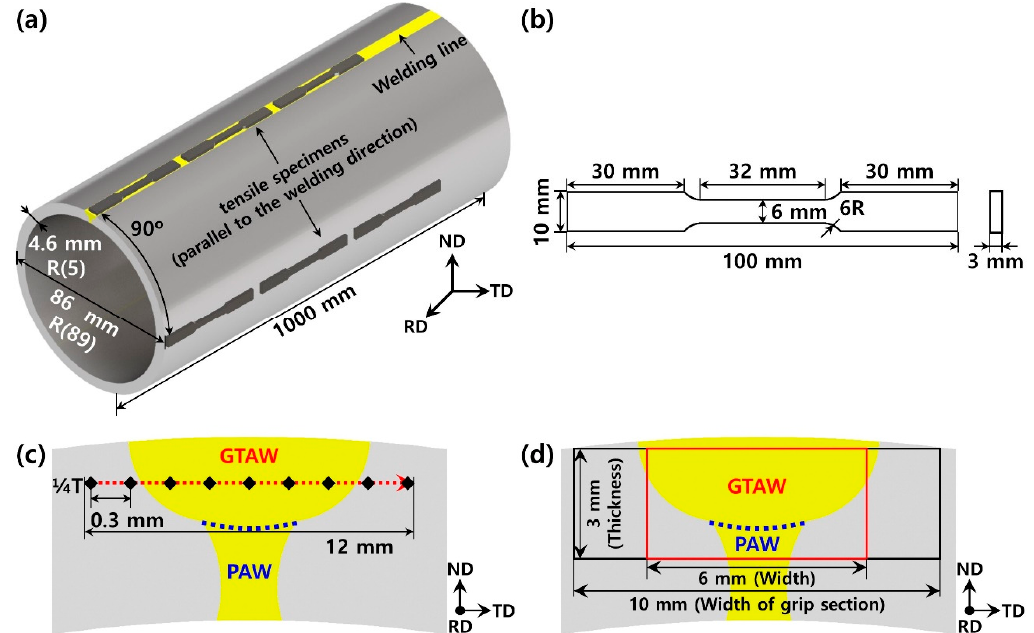
Figure 2. Schematic diagrams showing ( a ) location and direction of tensile specimens, ( b ) dimension of ASTM E8 Subsize tensile specimen, ( c ) location of Vickers hardness test, and ( d ) sampling location of tensile specimen.